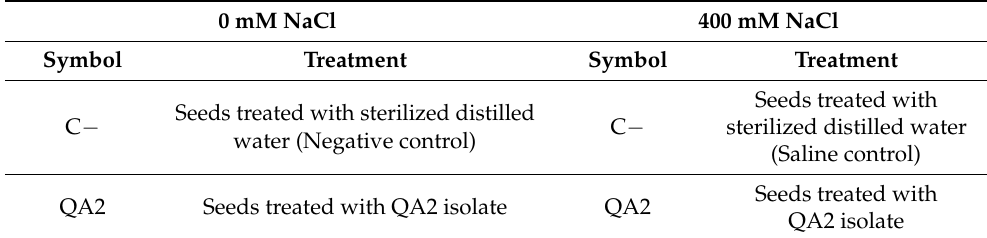
Table 1. Pot experiment work